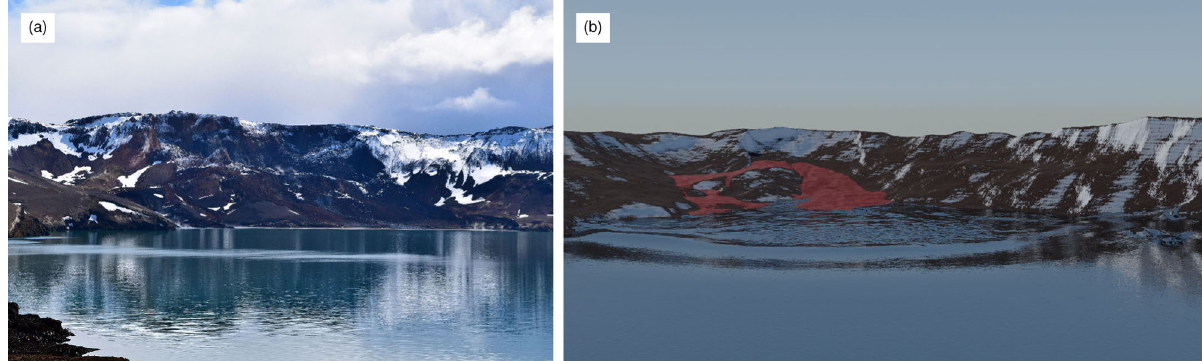
Fig. 1 Lake Askja landslide tsunami. a Photo of Lake Askja including the landslide scar and deposition from the 2014 landslide event (Picture: Kristinn I. Pétursson). b Rendered simulation of this event, showing the wave in the middle of the lake and the displaced landslide mass, highlighted in